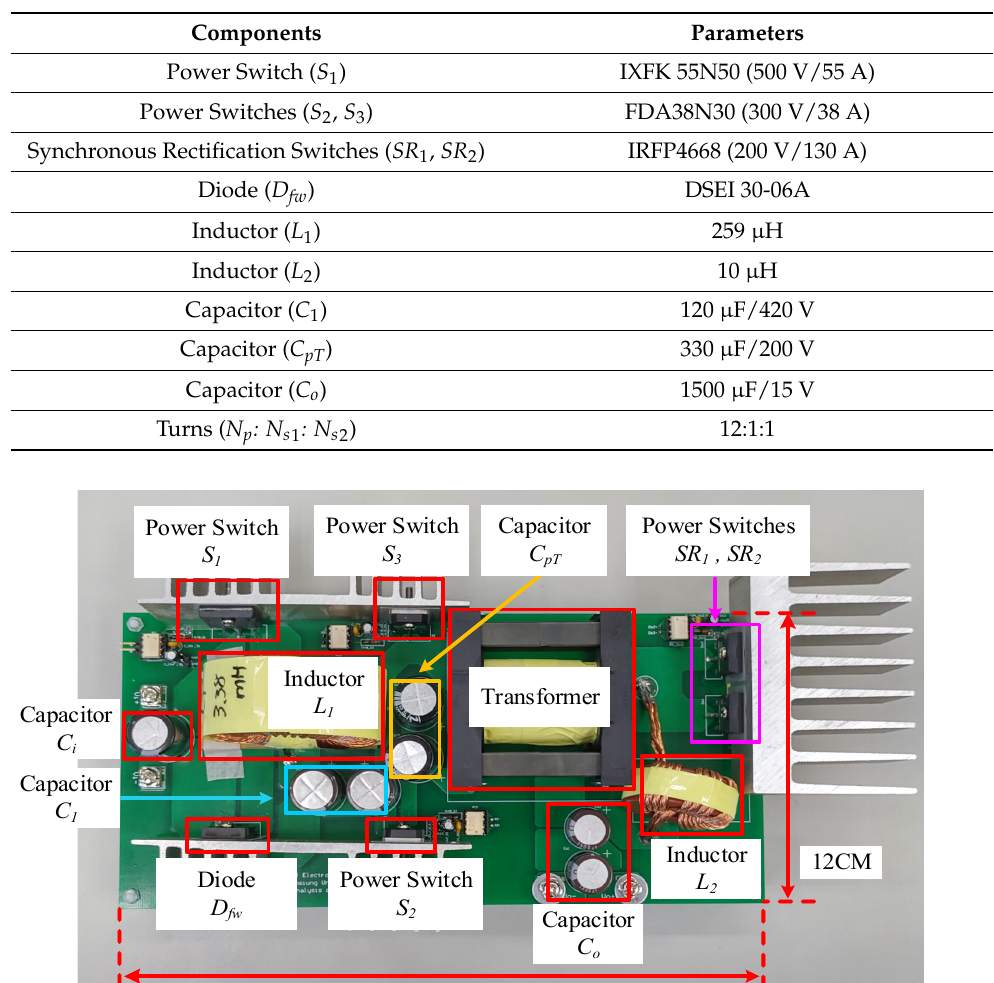
Table 1. Prototype specification of the proposed IBAHB.